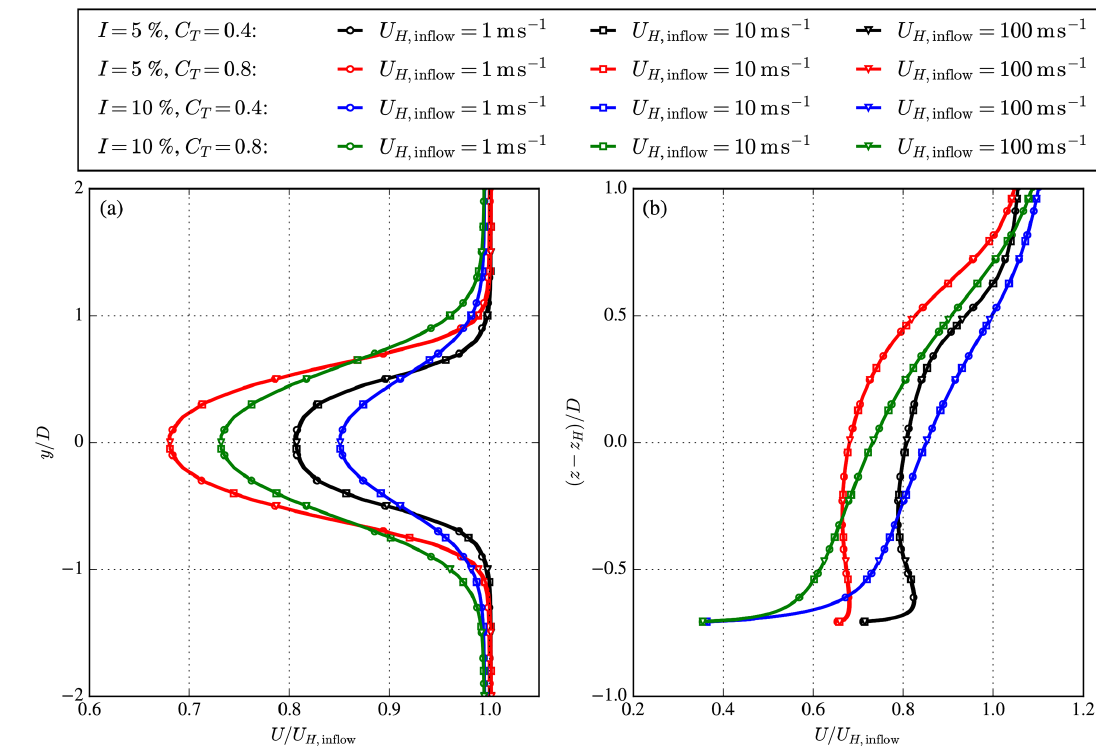
Figure A1. Reynolds number independence of the streamwise velocity deficit of a single AD with a prescribed thrust coefficient C T and ambient turbulence intensity I , at downstream distance of five rotor diameters. (a) Streamwise velocity at hub height as function of the lateral coordinate. (b) Streamwise velocity at y = 0 as function of the vertical